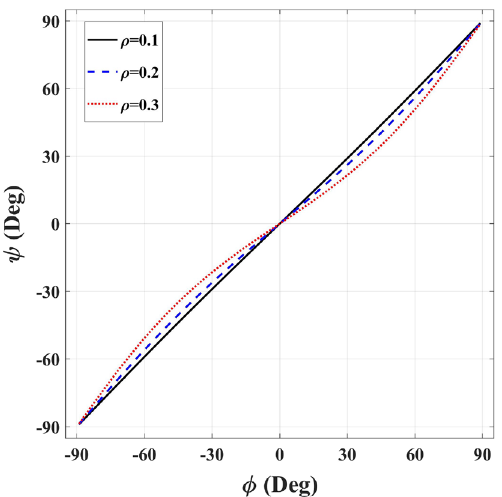
Figure 14. The angular coordinate of the virtual space ψ versus the angular coordinate of the physical space φ on the physical space’s outer contour for ρ = 0.1, 0.2 , and 0.3